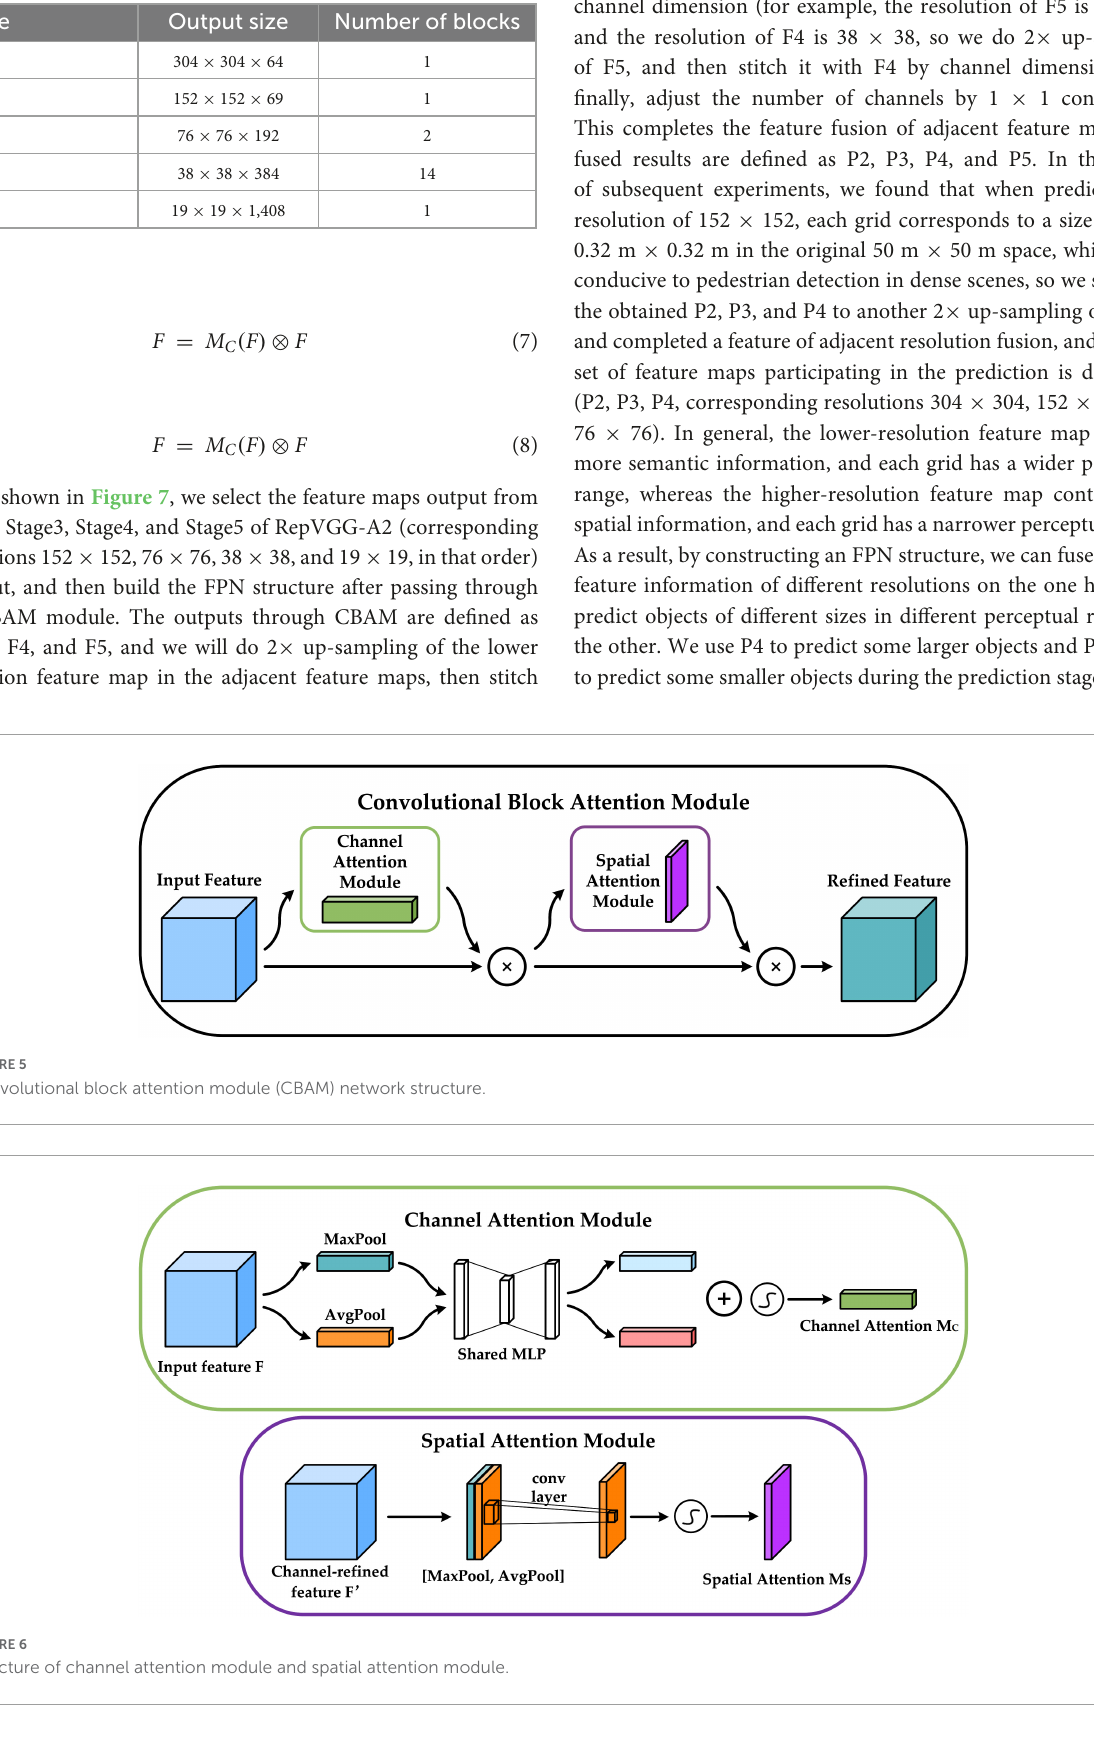
TABLE 1 RepVGG-A2 specific parameters.